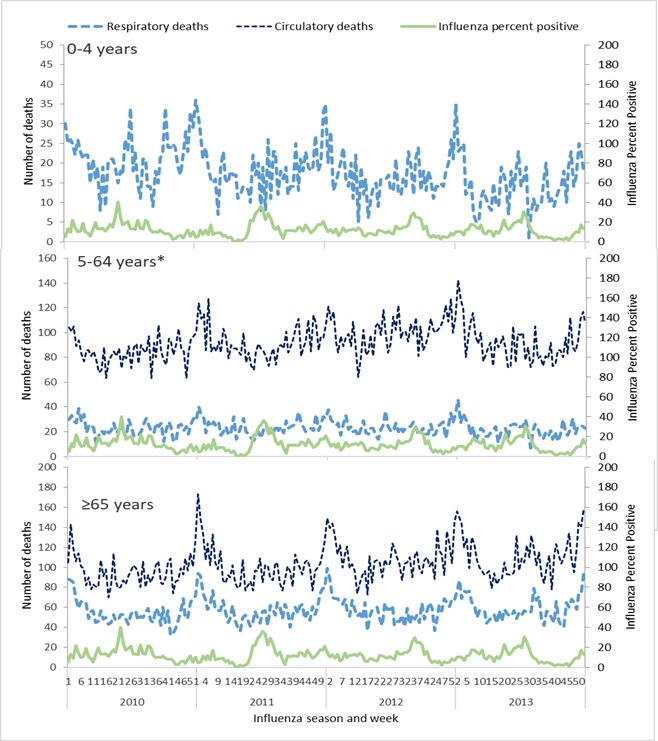
Sample registration system respiratory and circulatory coded deaths by week and influenza virus percent positive by week, India 2010-2013. *Circulatory deaths were for age group <65 years due to very small number of deaths in age group 0-4 years (includes under 5 circulatory deaths).